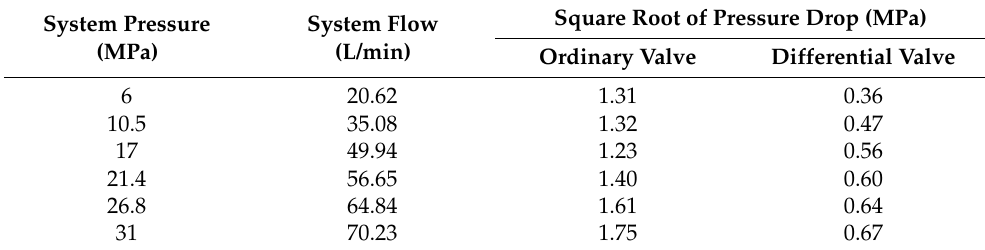
Table 4. Hydraulic cylinder extension data between ordinary valve and differential valve.